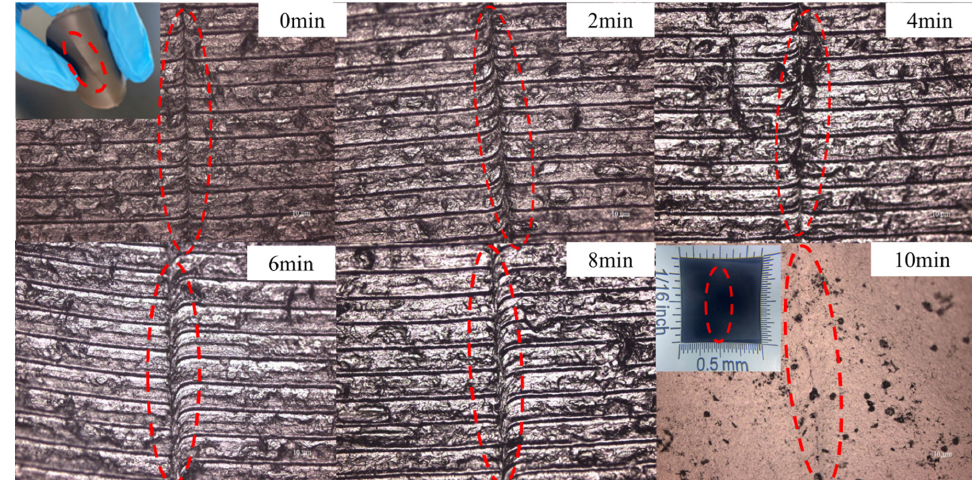
Figure 12. Optical micrographs of the self-healing of GO-TPU film with the TPU initial concentration of 20 wt % and 2 wt % GO under infrared light irradiation, and the inserts show the sample after scratched and self-healed.